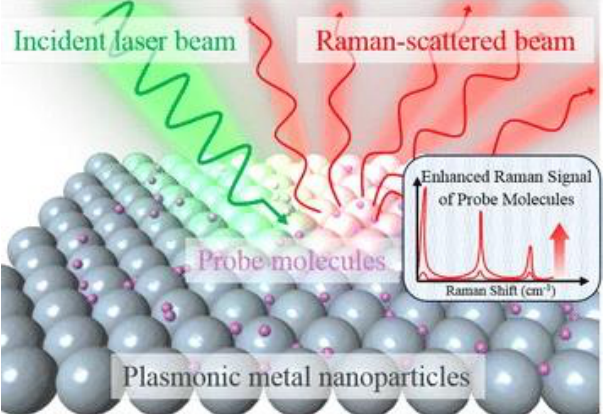
Figure 2. Schematic diagram of the SERS process. Reprinted from Jeon et al. [25]. Reprinted under CC BY 4.0. Ref.